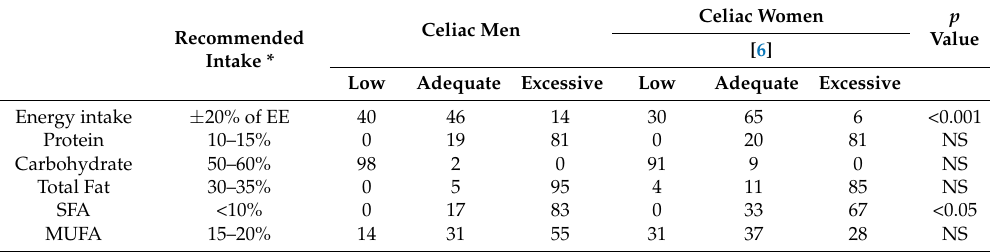
Table 3. Percentage of celiac men ( n = 42) and women ( n = 54) that fulfilled energy and macronutrient recommendation and their